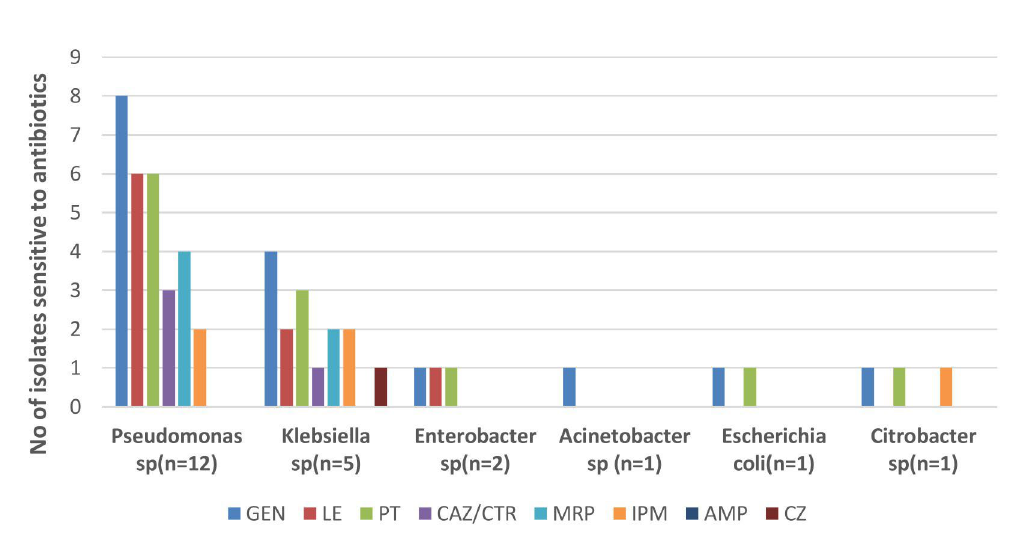
Fig. 3. Antibiotic sensitivity pattern of Gram-negative isolates from BAL fluid(n=22). PT= Piperacillin-Tazobactum: CAZ=Ceftazidime: CTR=Ceftriaxone: MRP=Meropenem: IPM= Imipenem: AMP= Ampicillin: